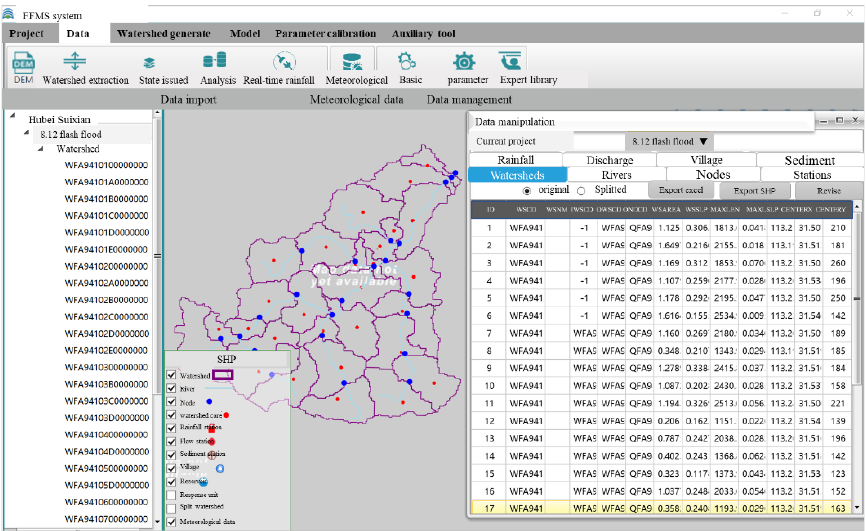
Figure 5. Calculation unit division in Liulin Town and land use attribute data extraction.